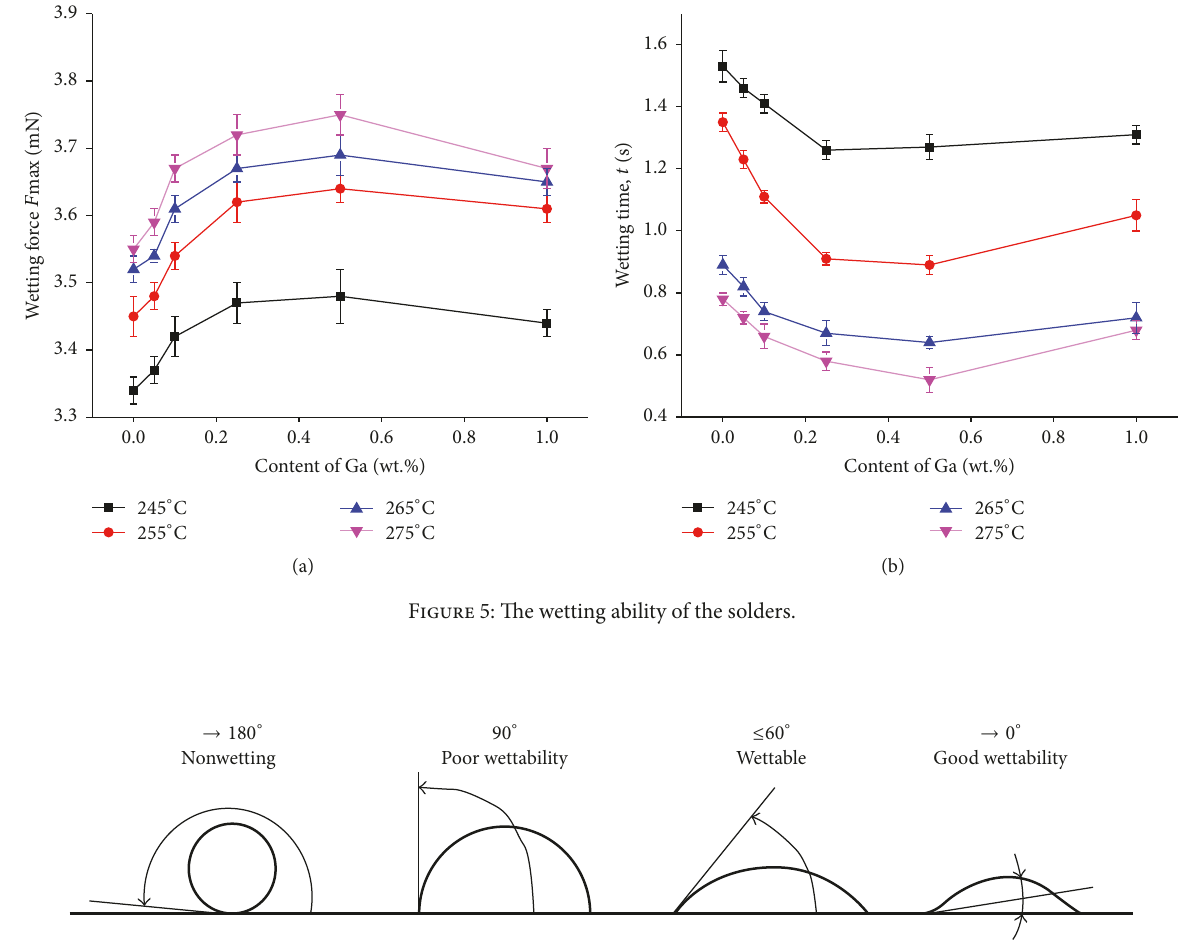
Figure 6: The wetting angles at different wetting